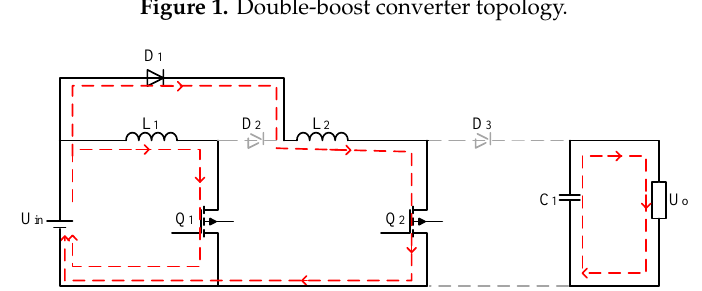
Figure 1. Double-boost converter topology.